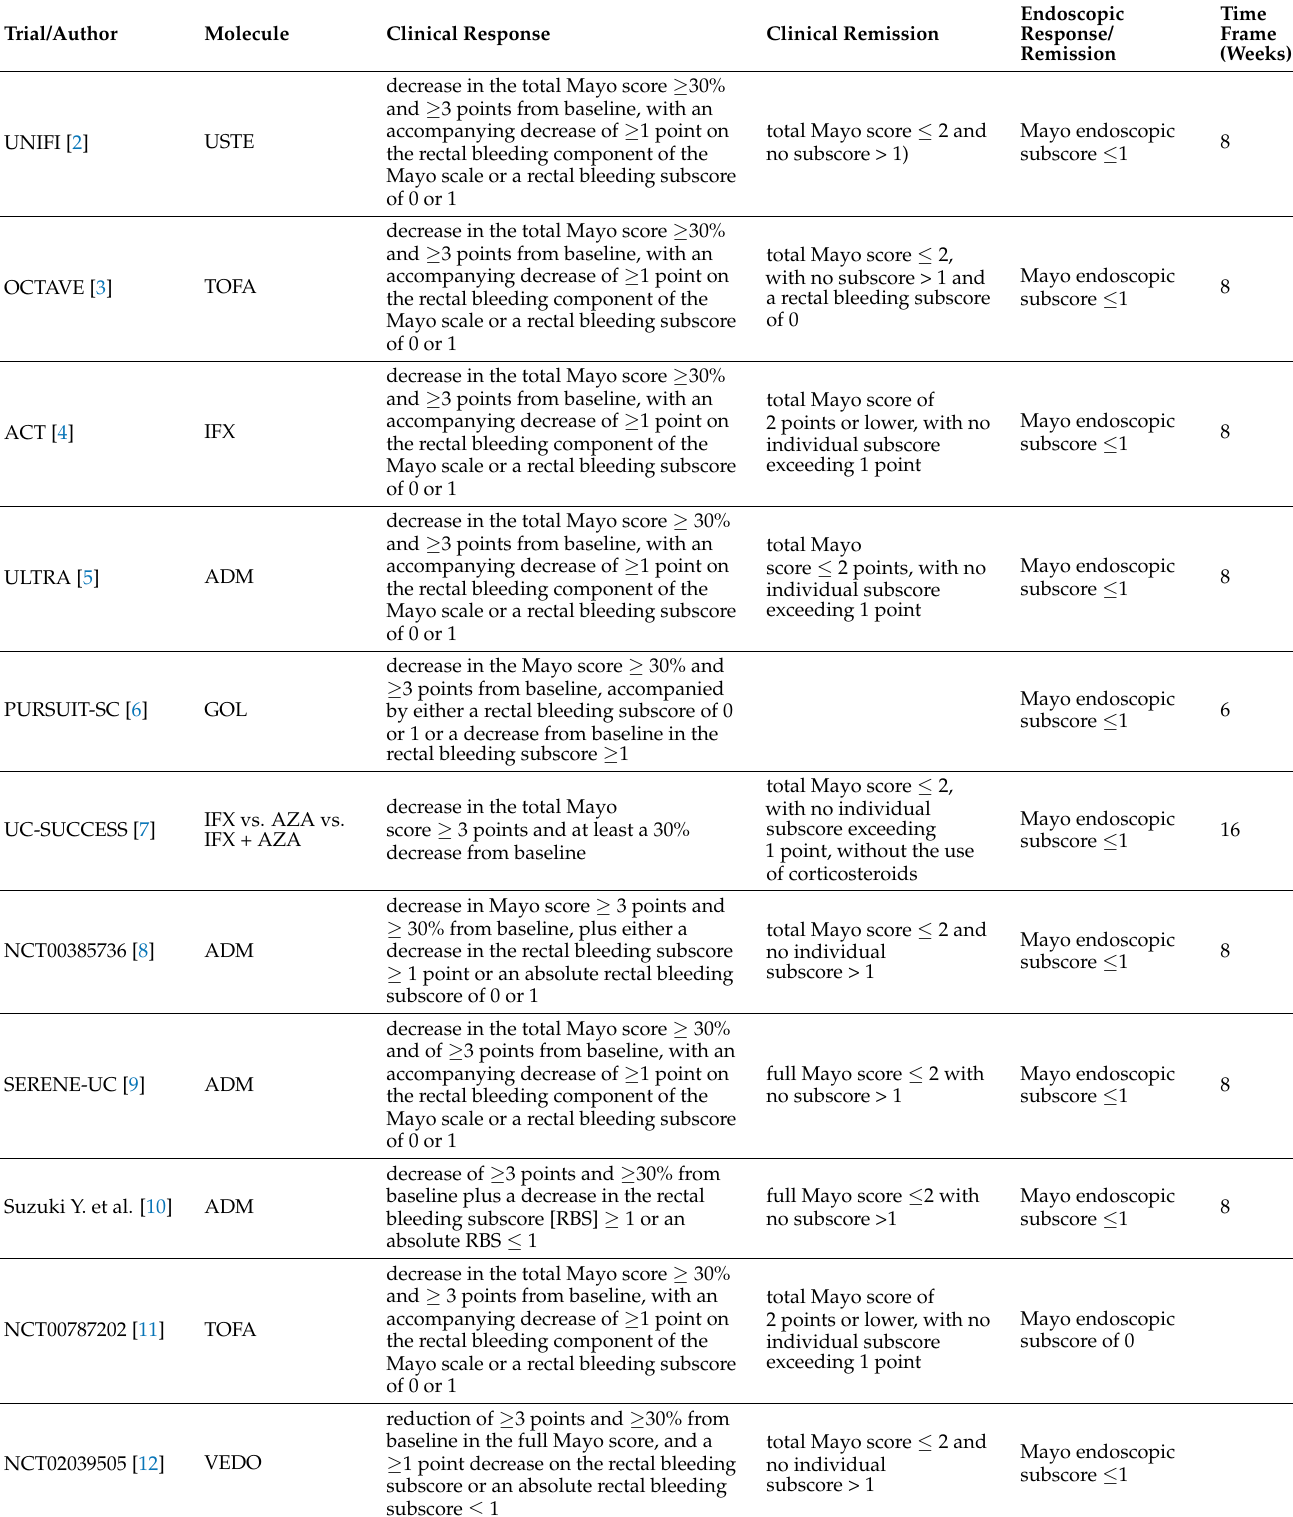
Table 1. Definitions of endpoints in ulcerative colitis clinical